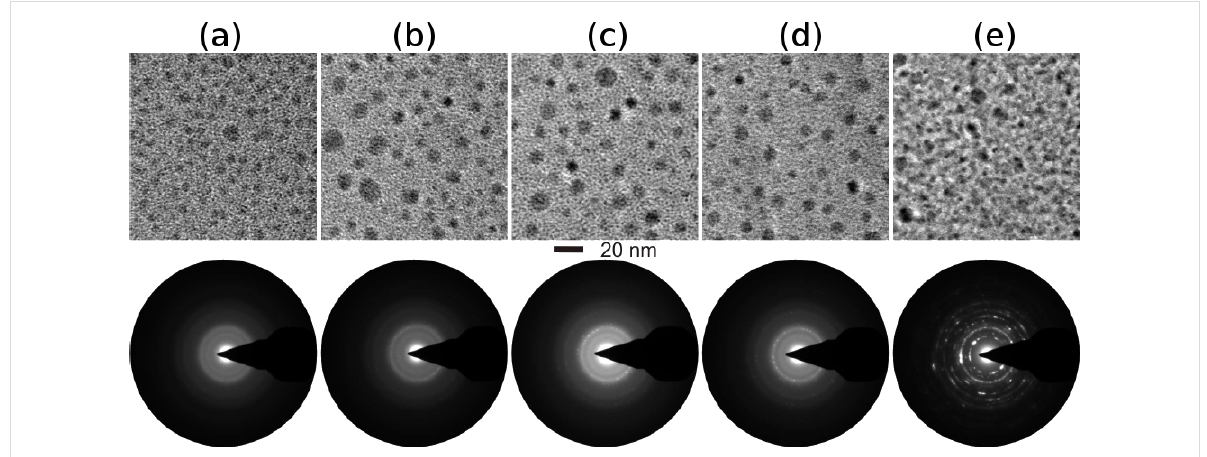
Figure 10: In situ heating of the Ag–TiO 2 nanocomposites at (a) room temperature (b) 150 °C, (c) 300 °C, (d) 400 °C and (e) 500 °C (total time: 3